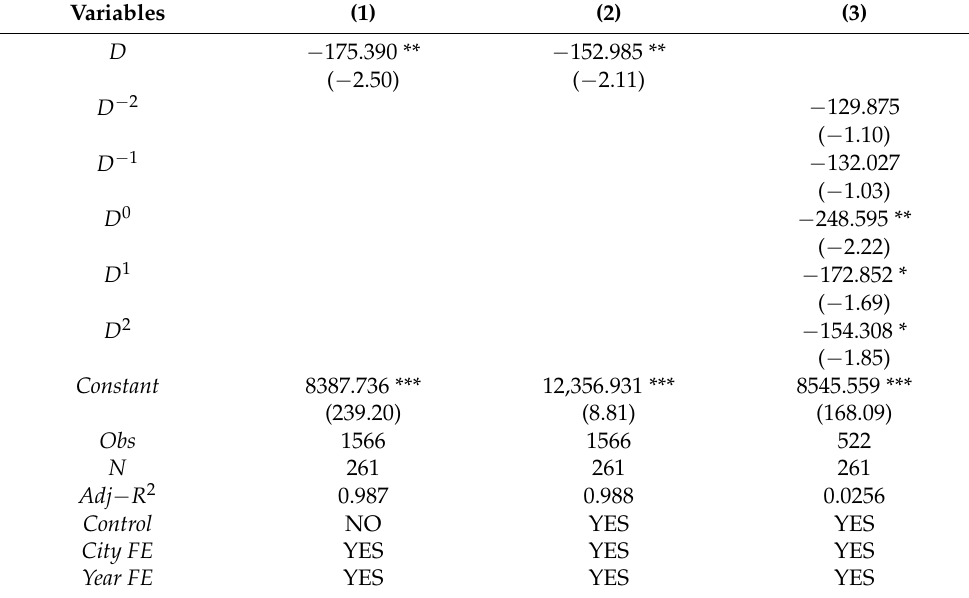
Table 3. DID regression results (Model